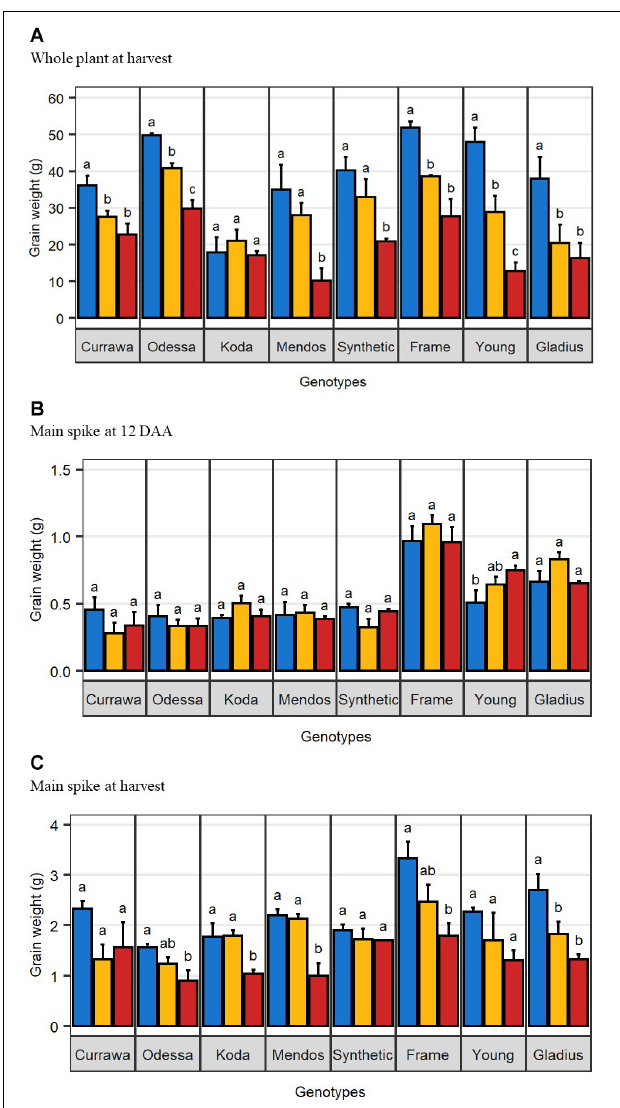
FIGURE 1 | Combined drought and heat stress differentially reduced final grain weight. (A) Mean total grain weight per plant at harvest ( n = 4). (B) Mean total grain weight in the main spike at 12 days after anthesis ( n = 3). (C) Mean total grain weight in the main spike at harvest ( n = 4). Error bars are standard error. Letters indicate the results of Tukey’s test comparing treatment effect within each genotype ( p < 0.1). Plants were grown under well-watered conditions (blue), drought (orange), or combined drought and heat (red).